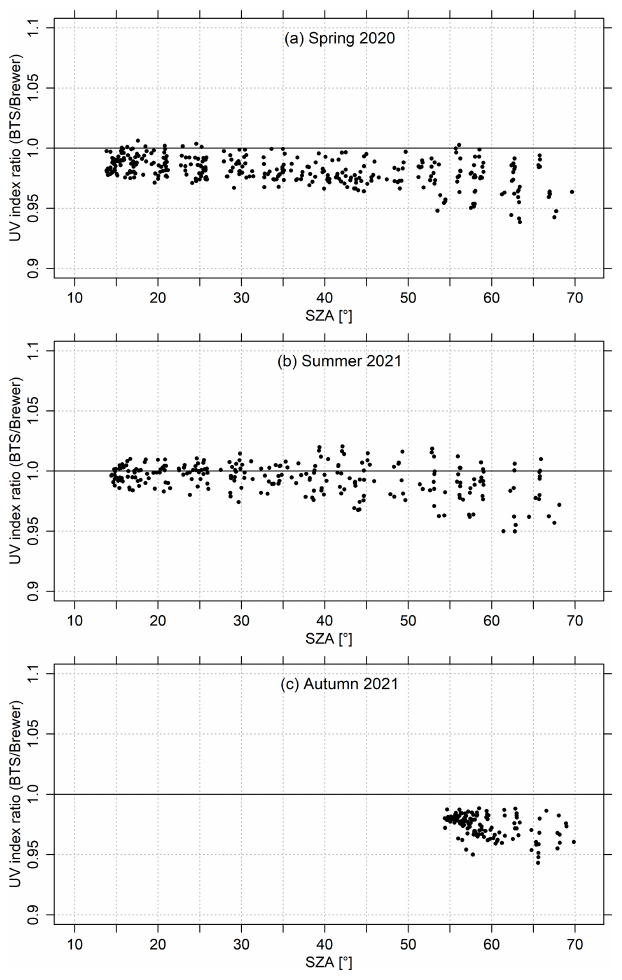
Figure 4. The ratio of UV indices between the BTS and the Brewer #150 as a function of solar zenith angle. The measurements were obtained from cloud-free conditions and SZAs lower than 70 ◦ dur- ing (a) spring 2020, (b) summer 2021 and (c) autumn 2021.